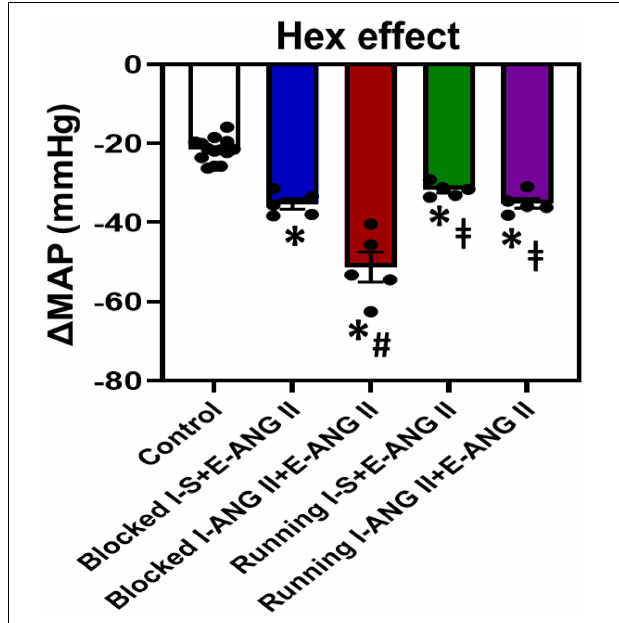
FIGURE 5 | Mean arterial pressure (MAP) in response to ganglionic blockade with hexamethonium (Hex) before starting the Induction-Delay-Expression (I-D-E) paradigm (control) and at the end of the pressor angiotensin (ANG) II infusion in all groups. ( n = 5/group; one-way ANOVA was used for analysis followed by Tukey’s post-hoc tests. p < 0.05, ∗ vs. control, # vs. Blocked I-S + E-ANG II, } vs. Blocked I + ANG II + E-ANG